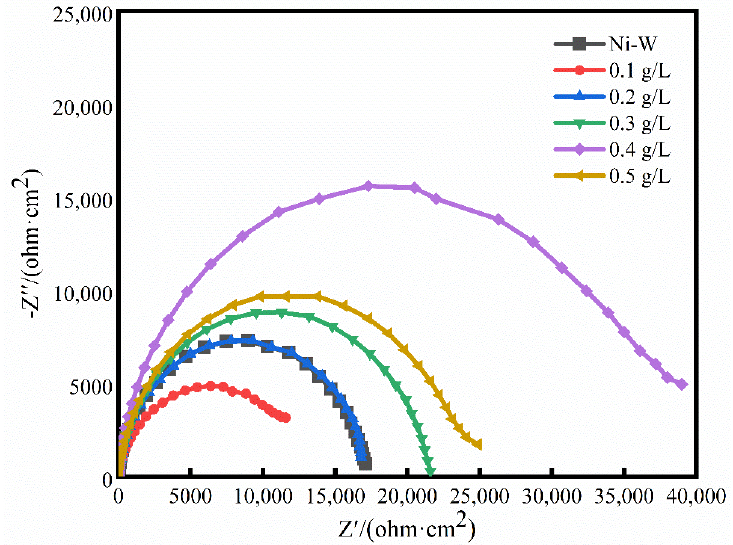
Figure 6. EIS of Ni-W-CF composite coatings with different concentrations of CF.